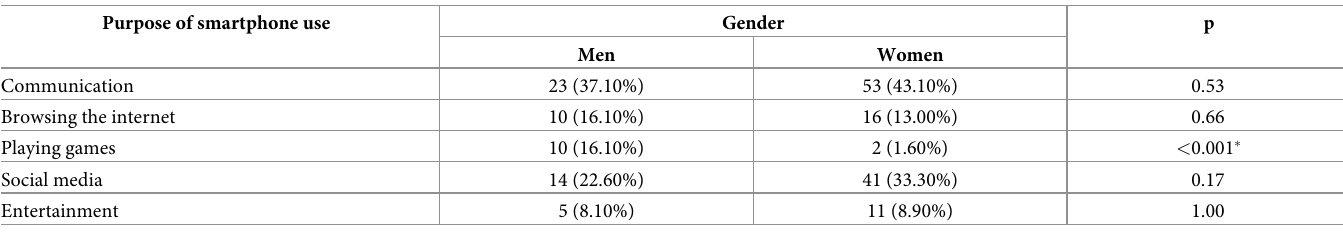
Table 3. Gender differences in the purposes of smartphone use.